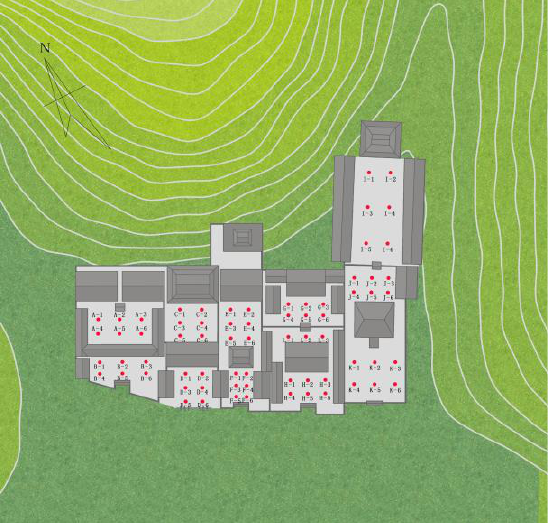
Figure 9. Schematic diagram of the wind and environmental measurement points in the buildings of the Bailudong Academy.